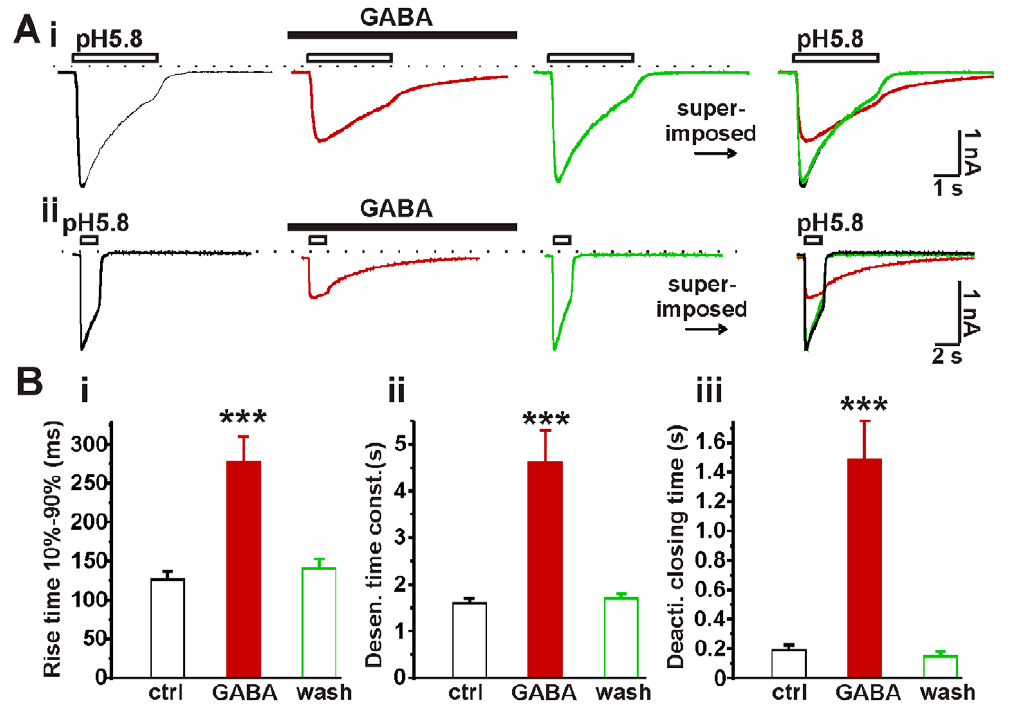
Figure 3. Activation of GABA A receptors modifies the current kinetics of ASICs. A, two representative current traces recorded from two hippocampal neurons (i and ii), respectively. ASICs were activated with pH 5.8 for 4 seconds (i) or for shorter 1.5 seconds (ii) to monitor the deactivation process of ASIC currents, GABA (100 m M) altered the overall shape of ASIC currents. ASIC current traces were superimposed to the right without scaling. B, bar graph showing the summarized data of rise time of activation (10–90%) (i), desensitization time constant (ii) and deactivation time (iii) of ASIC currents in the absence or presence of GABA. ***, paired t-test, p , 0.001, GABA group vs. control group, n=17–20.